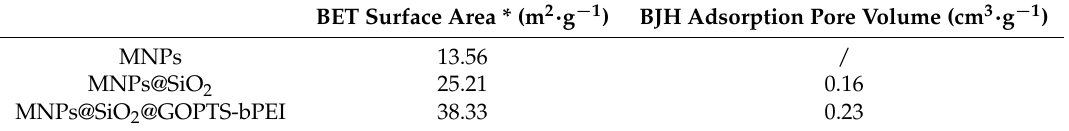
Table 2. Brunauer–Elmett–Teller (BET) surface area and pore volume for differently modified MNPs with respect to bare MNPs.